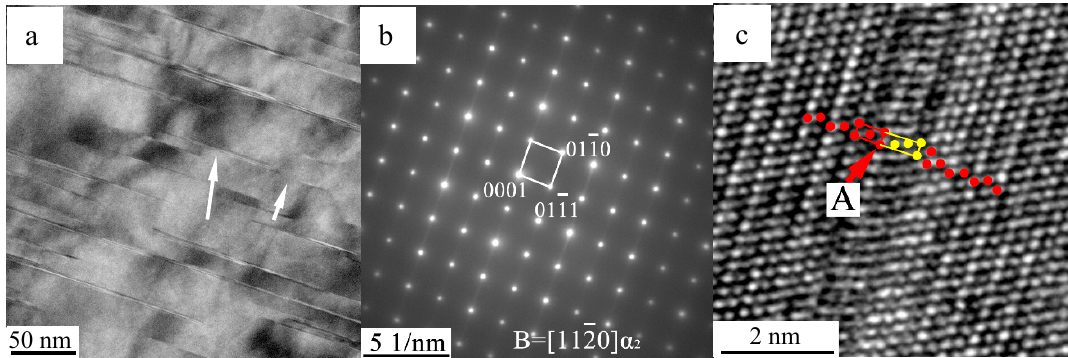
Figure 2. ( a ) Transmission electron microscopy (TEM); ( b ) selected area diffraction pattern (SADP) and ( c ) high-resolution transmission electron microscopy (HRTEM) images of the α m phase with stripes when annealed at 850 °C for 10 min. The red and yellow dots represent the stacking sequences of the γ phase (red dots) and precipitated stripes (yellow).